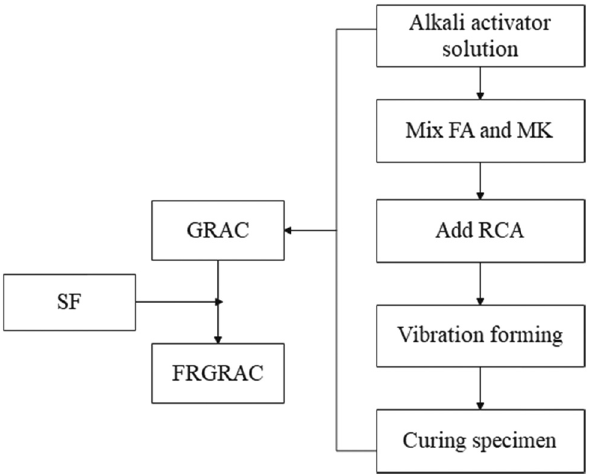
Figure 4: Maintenance of the cover fi lm.